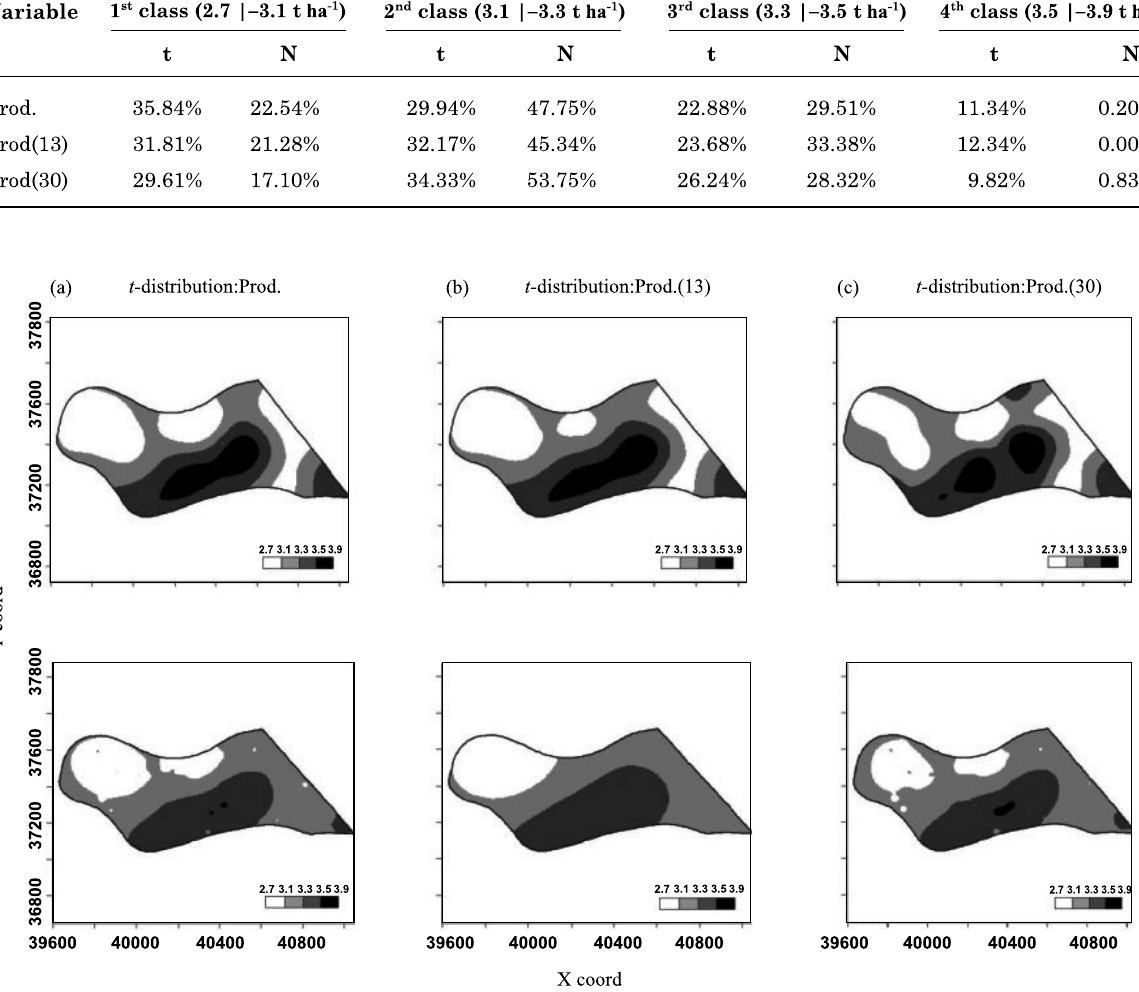
Figure 3. Soybean yield map - Gaussian